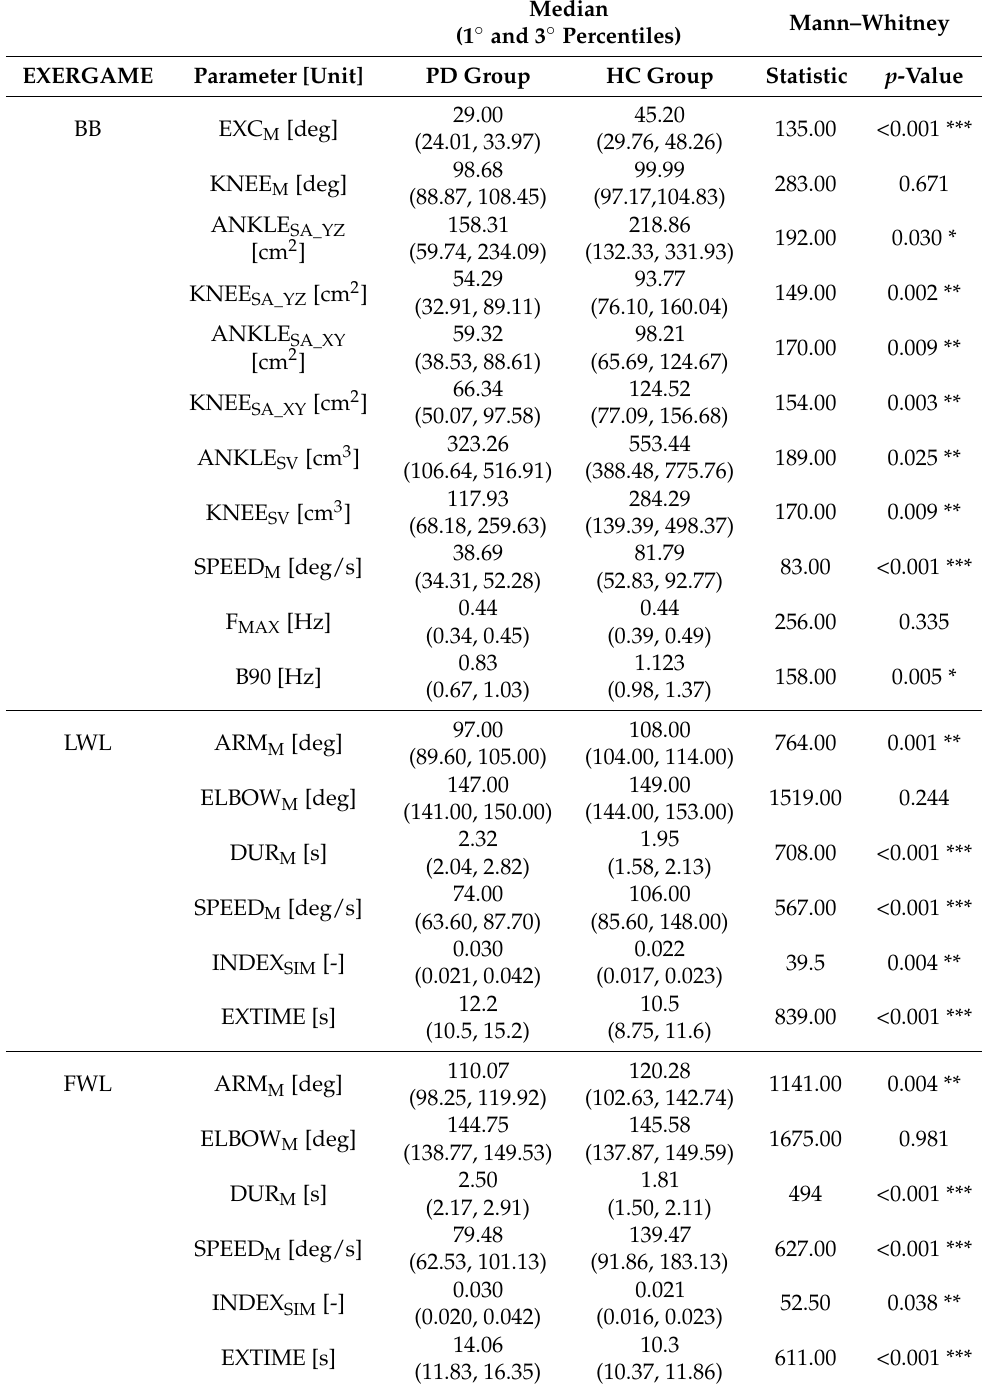
Table 4. Median and percentiles (first and third) estimated for PD and HC groups, for FWL, LWL, and BB exergames, with test statistic, p -value, and significance